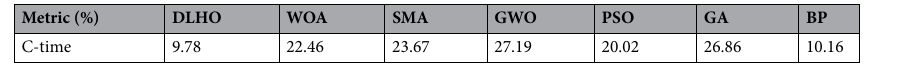
Table 10. Computational time of algorithms on MIAS database for cancer